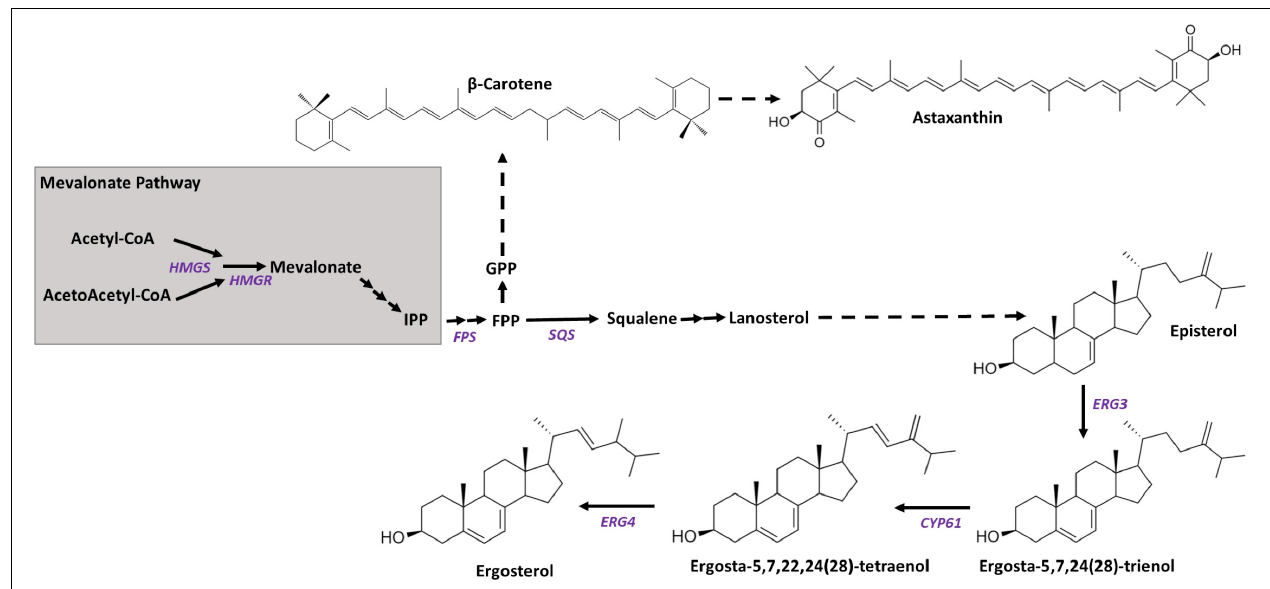
FIGURE 1 | Scheme of the mevalonate pathway and the synthesis of carotenoids and sterols. Arrows represent catalytic steps with the corresponding enzyme-encoding gene studied in this work. Gene names are written in purple, and their GenBank accession numbers are HMGS (XDEN_03265), HMGR (GenBank: AJ884949), ERG3 (GenBank: MN930922), ERG5/CYP61 (GenBank: JX183236), and ERG4 (GenBank: MN930923). The final steps of ergosterol biosynthesis correspond to steps described in S. cerevisiae steroid biosynthesis at the KEGG database